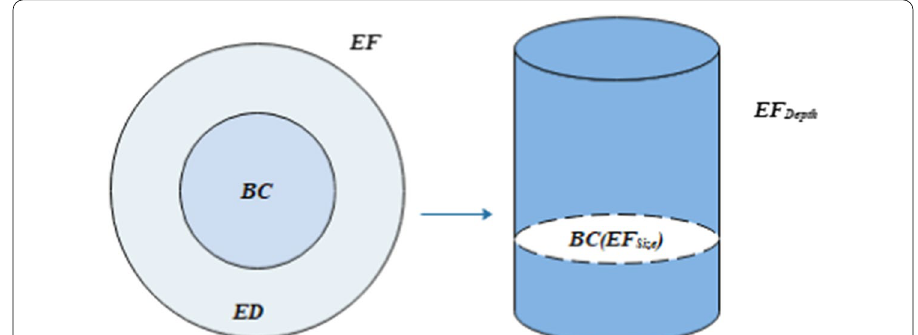
Fig. 2 Evolution of ecological footprint model from two to three